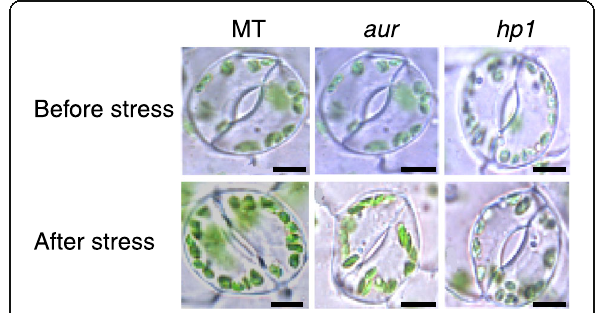
Fig. 2 Effects of chilling stress on stomatal aperture of tomato photomorphogenic mutants. The changes in stomatal aperture of tomato aur and hp1 mutants and the wild-type genotype (MT) were observed before and after chilling stress. The lower surfaces of the leaves with or without stress were examined under a